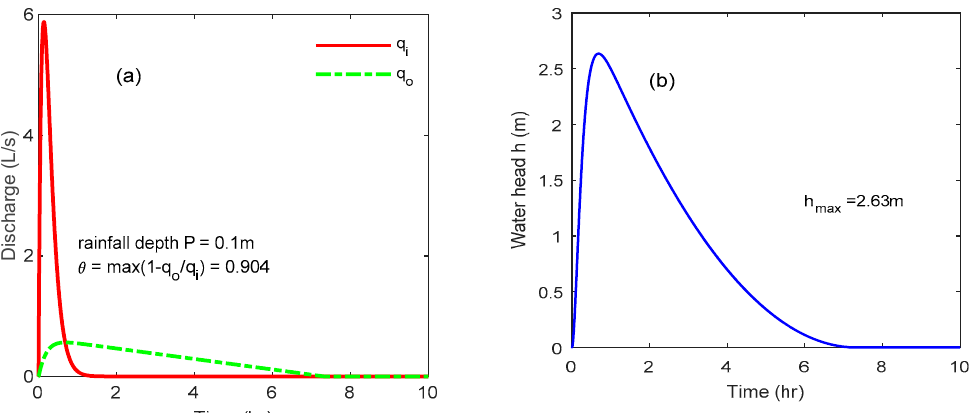
Figure 6. Decreasing the cross-sectional area of the drain orifice greatly extends the discharge time. ( a ) Discharge flow; ( b ) water head in the tank.